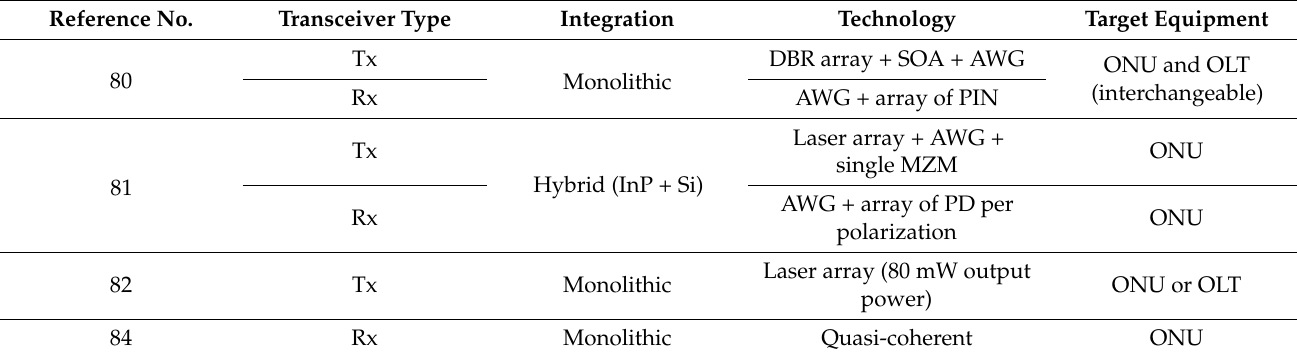
Figure 5. Diagram comparing the ONU based on discrete optics and the novel PIC based ONU [84]. Table 2. Summary of key parameters of PIC based NG-PON2